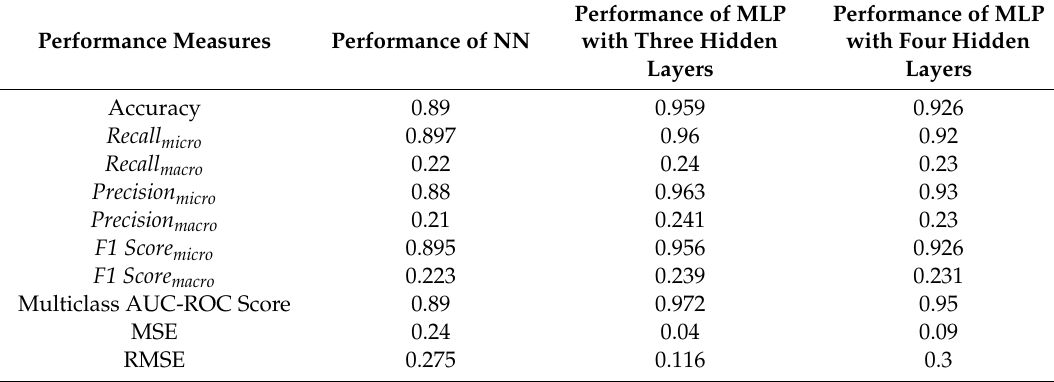
Table 4. Performance of NN and MLP with N h = 30 for multiclass classification averaged over ten independent